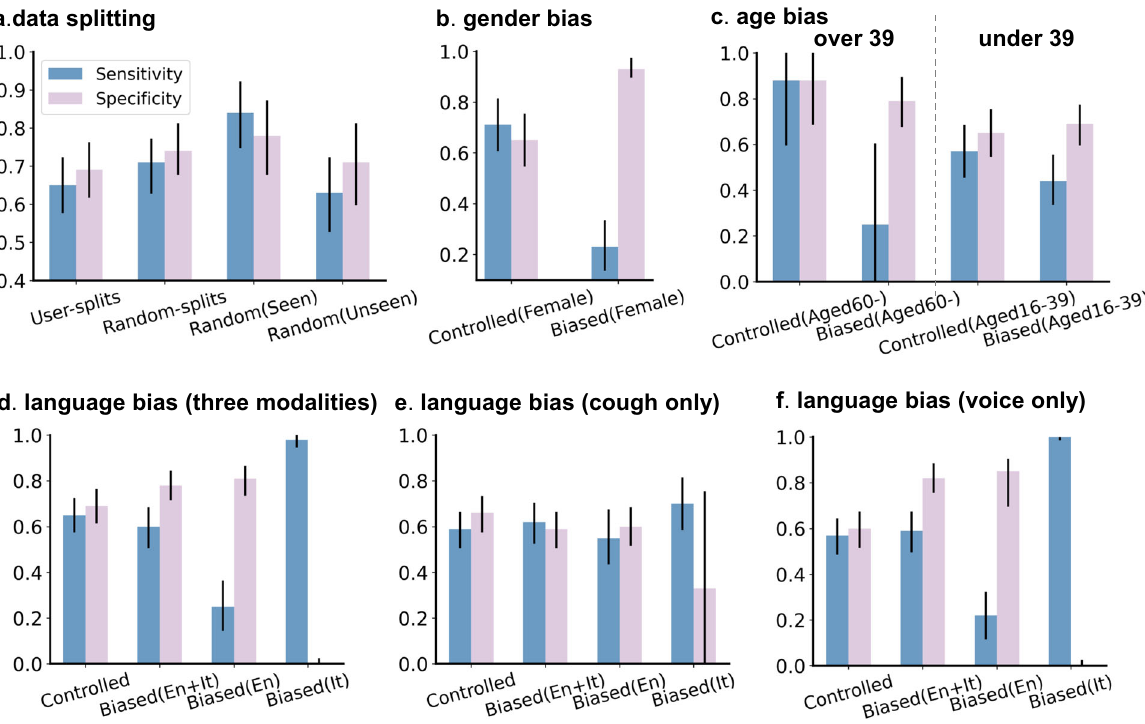
Fig. 4 Performance comparison. Sensitivity (blue) and speci fi city (pink) are presented with sold liner showing the 95% CIs. If not particularly mentioned, the results are based on the combination of three sound types. a User-independent splits vs. sample-level random splits: (Seen) denotes the performance on samples whose other samples were used for training, otherwise the performance is notated by (Unseen). b Controlled demographics vs gender bias: (Female) denotes the female subgroup. c, Controlled demographics vs two types of gender biases: all negative participants in training set aged over 39 or under 39. (Aged 60-) and (Aged 16 – 39) denote the elder and the younger subgroup. d – f Model for English-speakers vs model for biased English- and Italian-speakers: (En) and (It) denote two subgroups from the testing